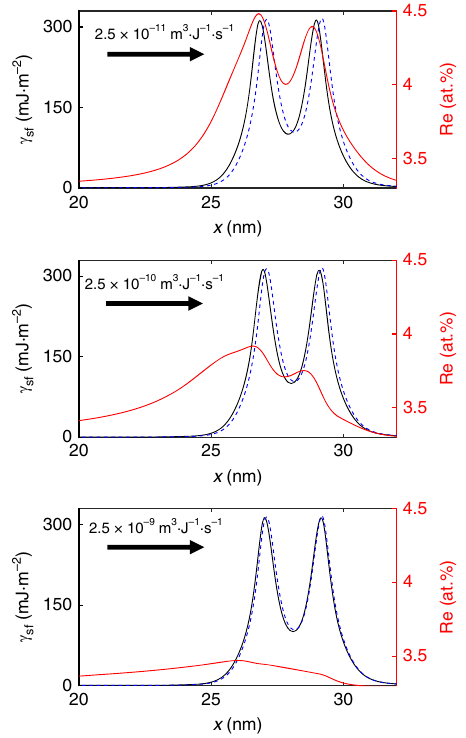
Fig. 8 Phase- fi eld of dislocation/SF energy and composition pro fi les for moving dislocations. Snapshots of dislocation/SF energy pro fi les with (solid black line) and without (dashed blue line) Re as well as the corresponding Re concentration (solid red line) in γ . The direction of dislocation motion is marked by arrows together with the average dislocation mobilities (velocities): a 2.5 × 10 − 11 m 3 J − 1 s − 1 (0.2 nm s − 1